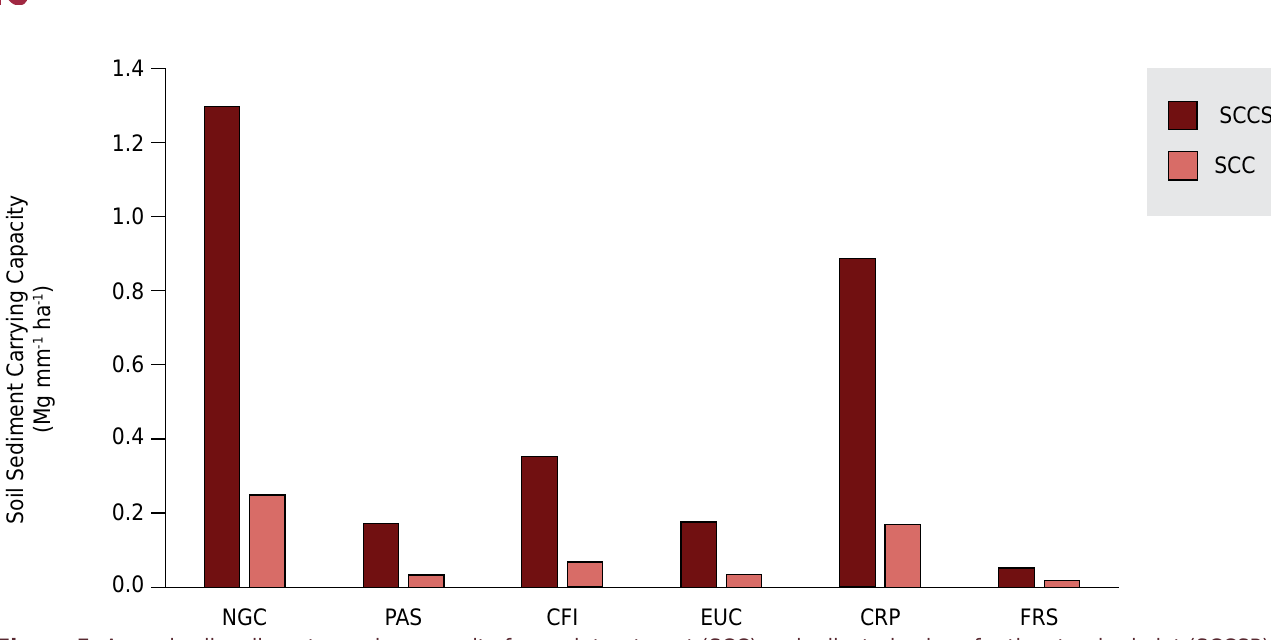
Figure 5. Annual soil sediment-carrying capacity for each treatment (SCC) and adjusted values for the standard plot (SCCSP), with slope of 0.09 m m -1 . NGC: no ground cover, PAS: pasture, CFI: crop-forest integration, EUC: eucalyptus plantation, CRP: soybean and corn crop succession, FRS: